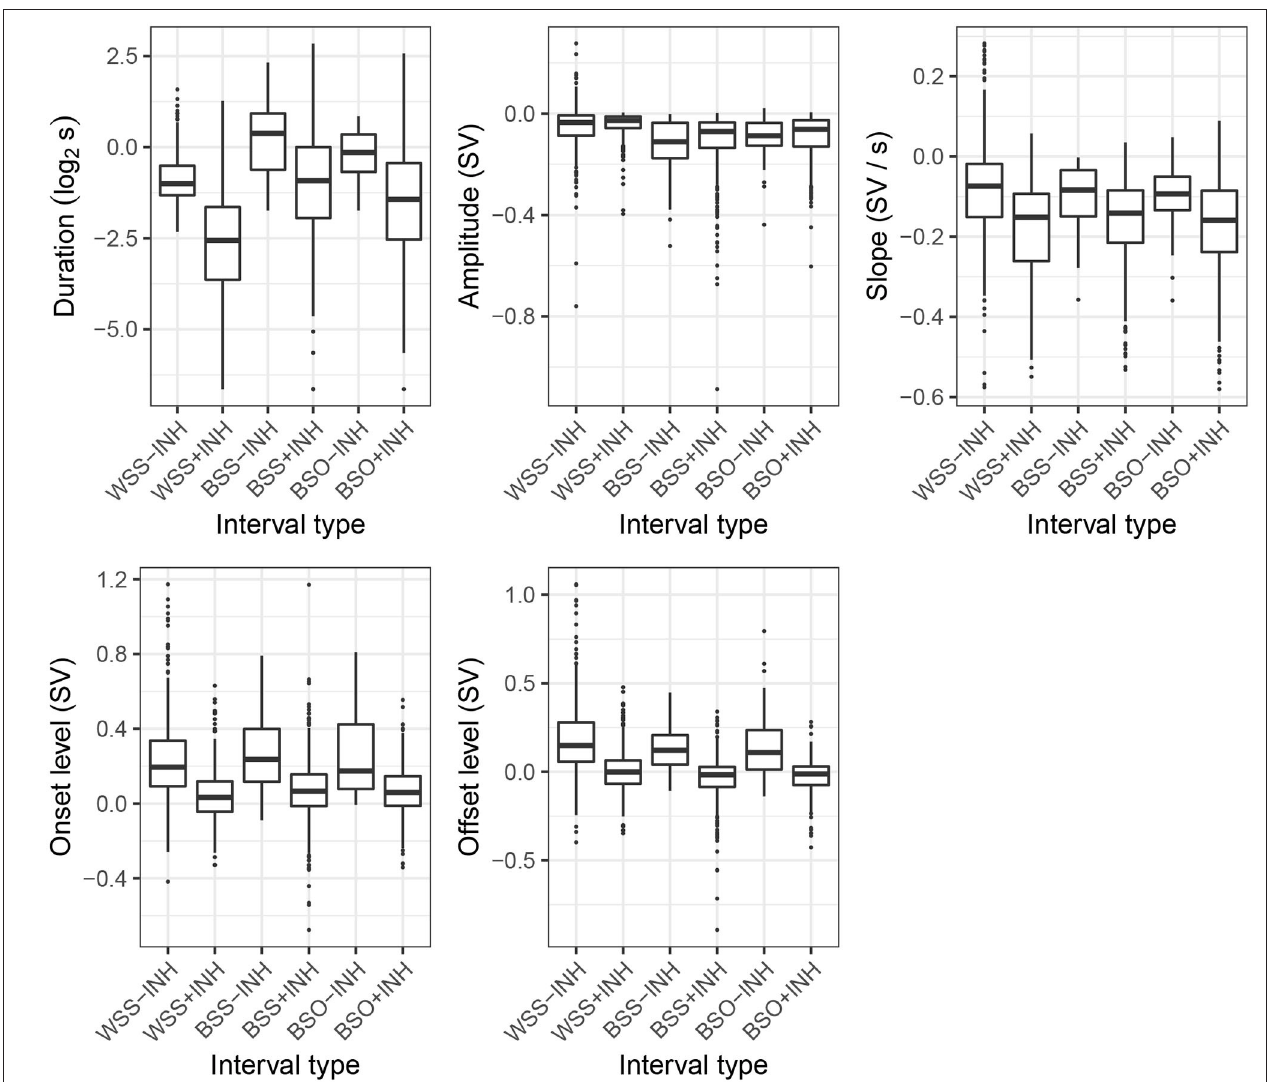
FIGURE 5 | Distributions of exhalatory features across the interval types. See section 3 for explanation of the categories.